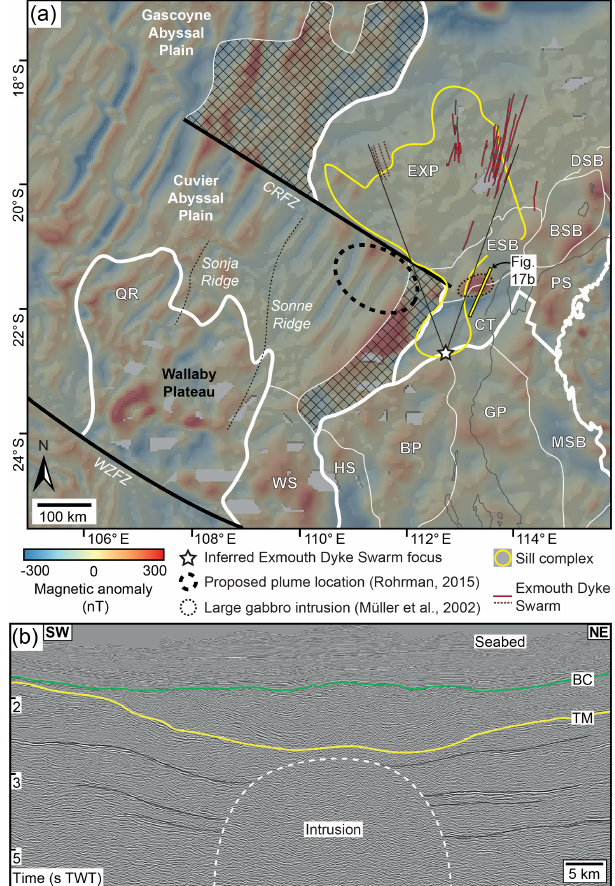
Figure 17. (a) Tectono-magmatic elements of the north and south Carnarvon Basins, including the inferred extent of the Exmouth Dyke Swarm and its focal area, overlain on a map of total magnetic intensity grid (EMAG2v2). Also highlighted are a proposed plume conduit site (Rohrman, 2015) and location of a large, mafic intrusion (Müller et al., 2002). Tectonic elements highlighted include EXP = Exmouth Plateau; DSB = Dampier Sub-basin; BSB = Barrow Sub-basin; ESB = Exmouth Sub- basin; CT = Carnarvon Terrace; MSB = Merlinleigh Sub-basin; PS = Peedamullah Shelf; GP = Gascoyne Platform; BP = Bernier Platform; HS = Houtman Sub-basin; WS = Wallaby Saddle; QR = Quokka Rise; CRFZ = Cape Range Fracture Zone; and the WZFZ = Wallaby-Zenith Fracture Zone. (b) Interpreted seismic section across the large mafic intrusion highlighted in (a)